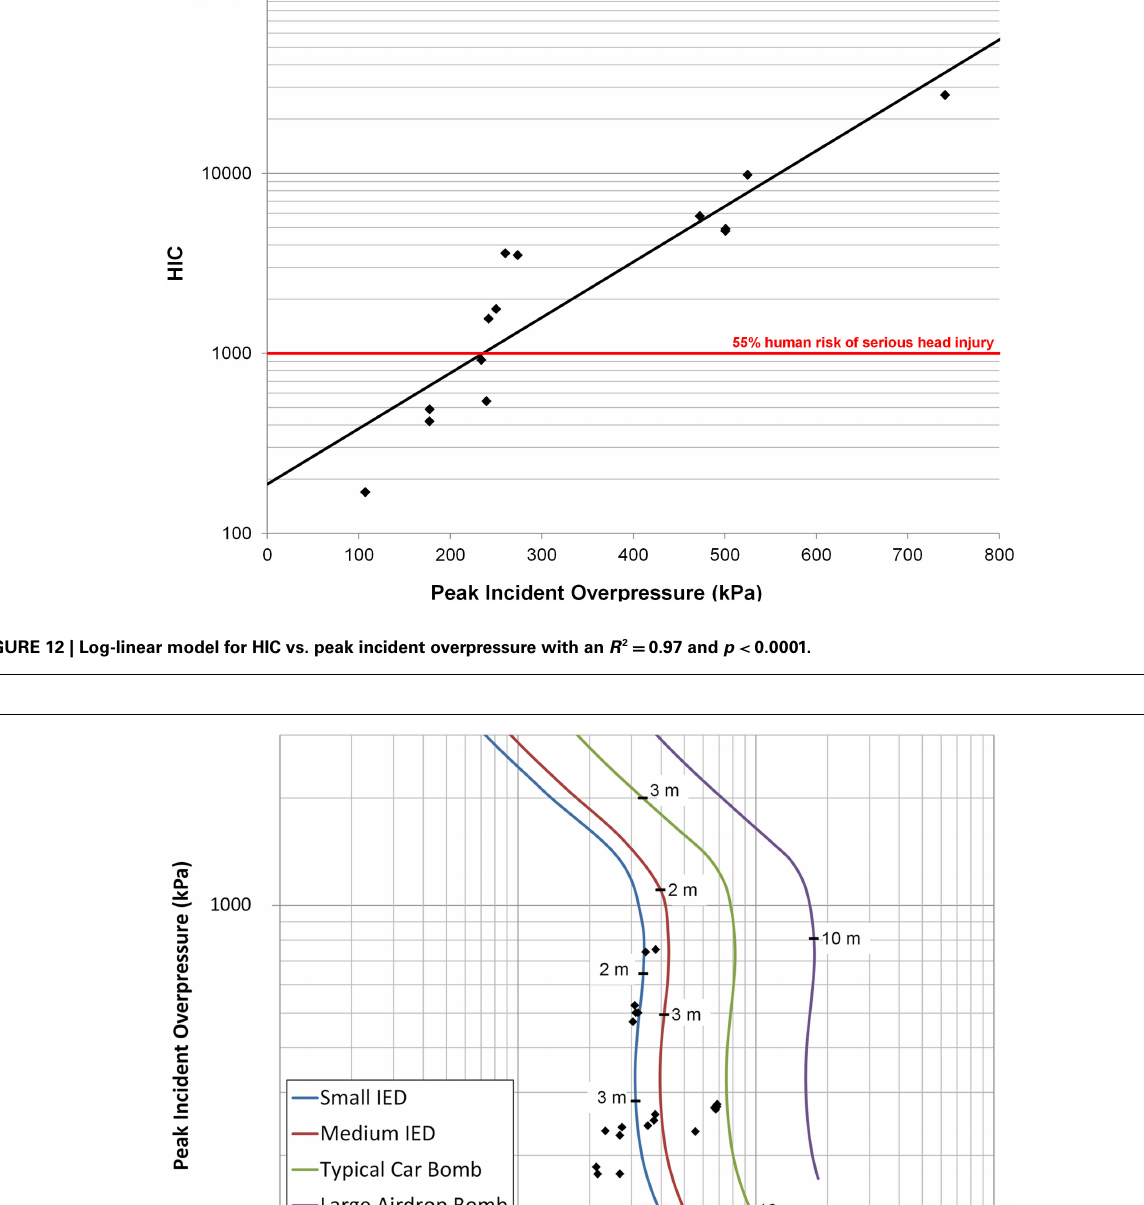
previously mentioned, any incident blast wave that impinges on an object can theoretically increase between two and eight times during its reflection (Iremonger, 1997). Therefore, ICPs must be compared to the actual reflected surface pressure on the skull